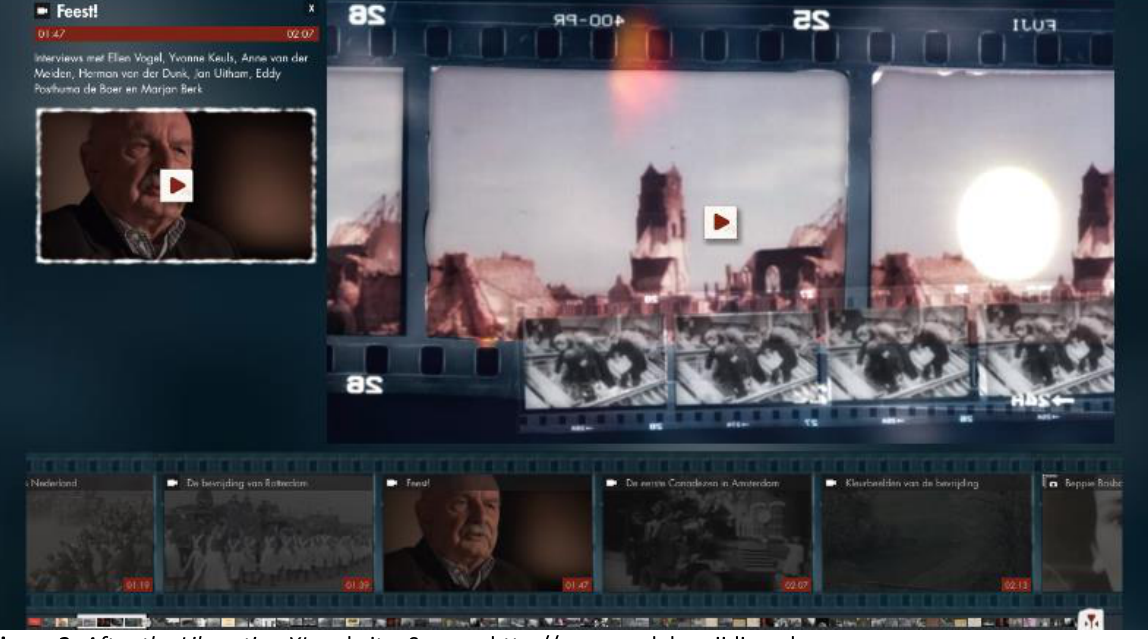
Figure 3. After the Liberation XL website. Source: